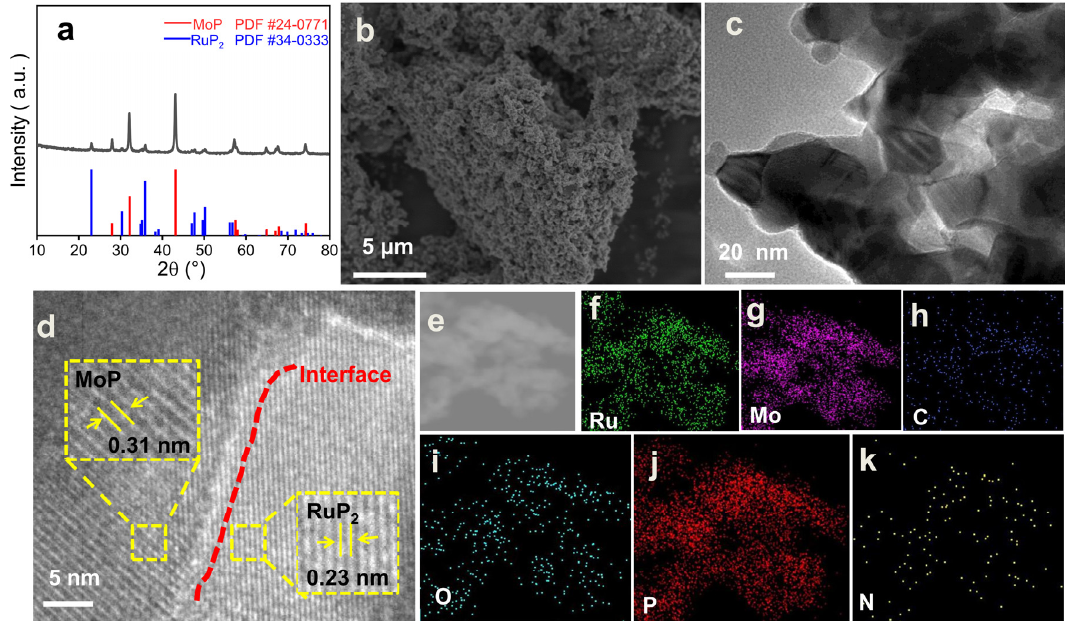
Figure 1. XRD ( a ), SEM ( b ) and TEM ( c ) images of MoP-RuP 2 @NPC; ( d ) HRTEM image; ( e ) TEM/EDS image; ( f – k ) elemental mapping images for Ru, Mo, C, O, P and N.